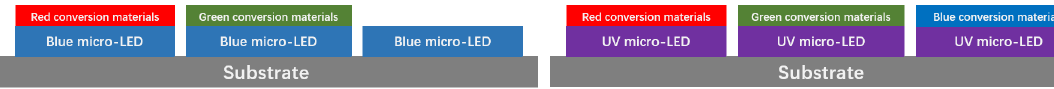
Figure 7. Schematic diagram of color conversion technology.